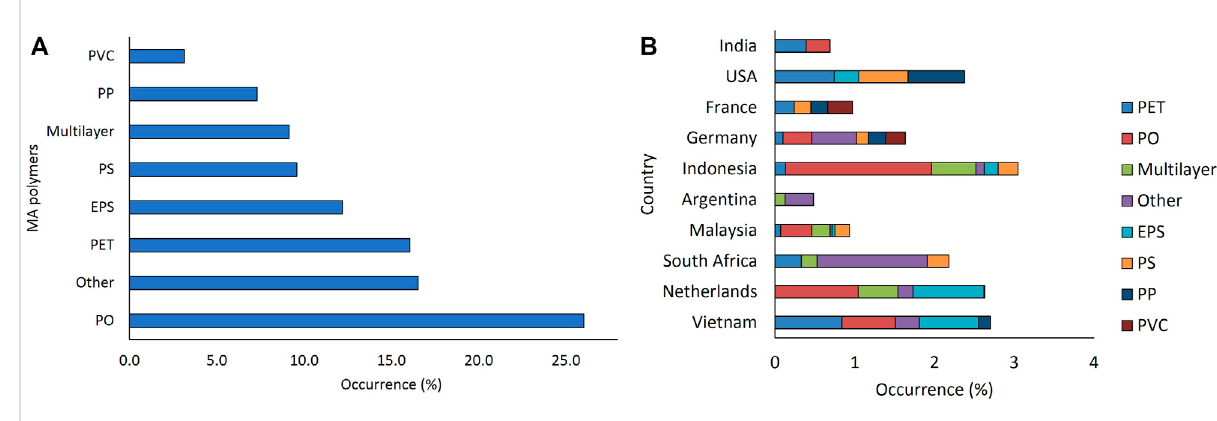
FIGURE 12 Most occurring macroplastic (MA) polymers (A) in rivers worldwide among countries (B)